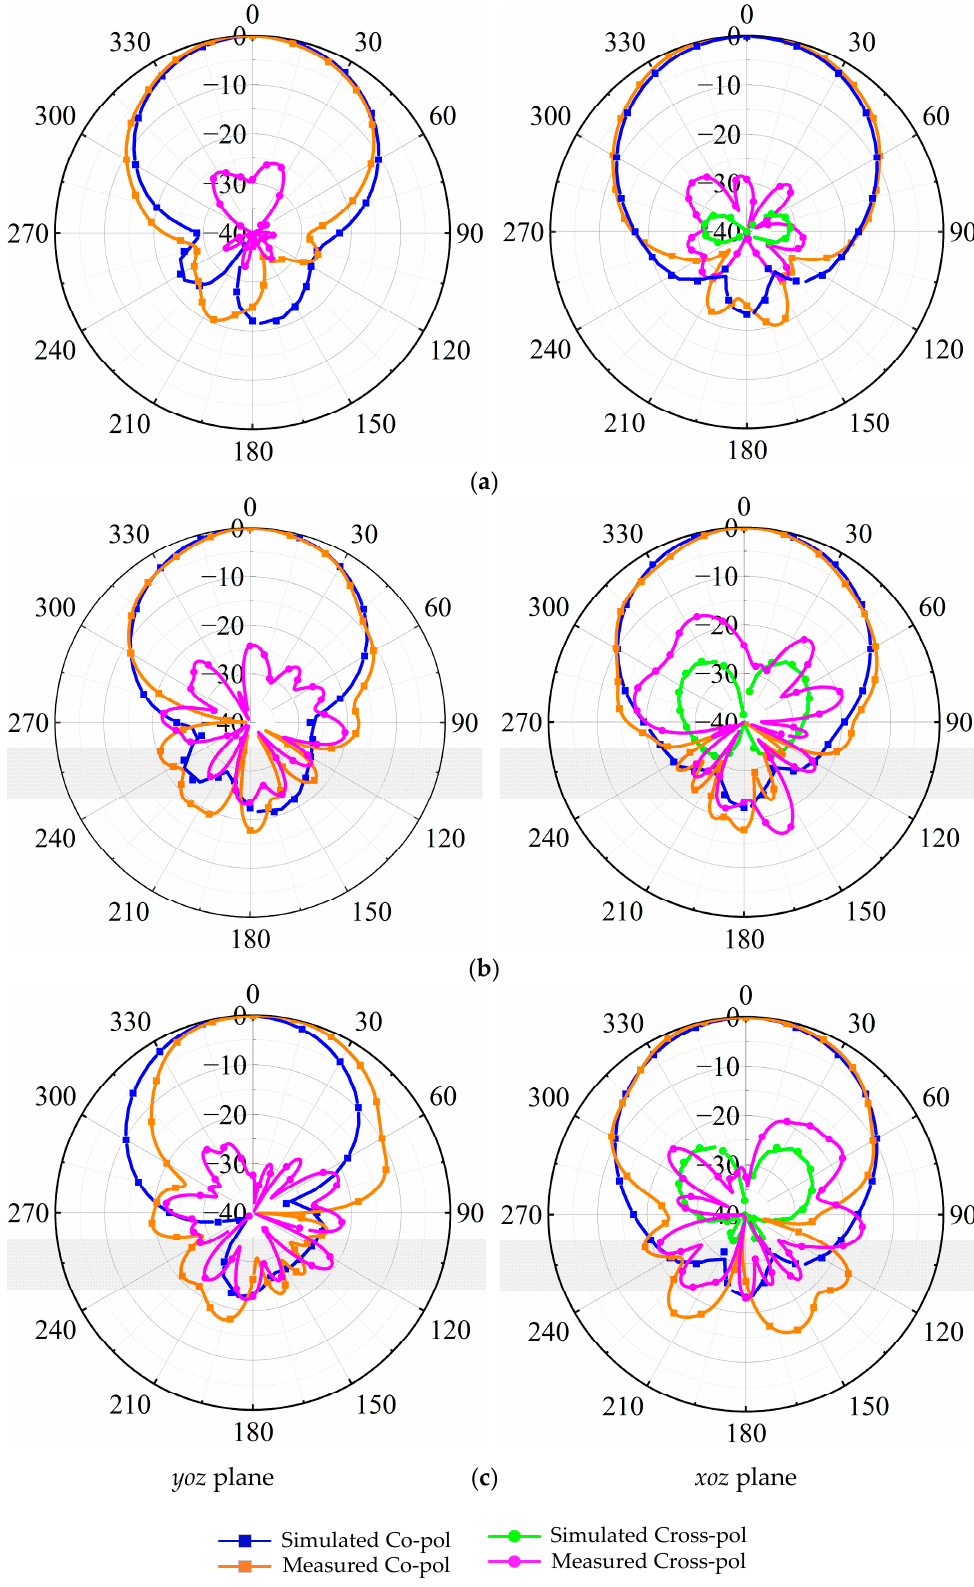
Figure 12. Radiation patterns at different frequencies. ( a ) 3.3 GHz. ( b ) 3.58 GHz. ( c ) 3.84 GHz.